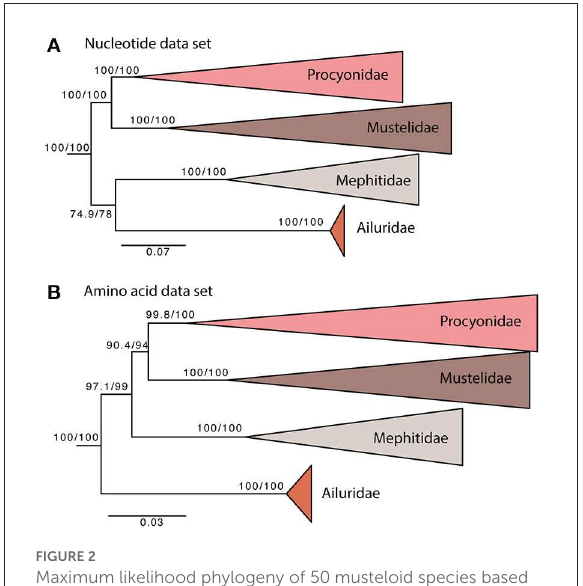
FIGURE2 Maximum likelihood phylogeny of 50 musteloid species based on nt (A) and aa (B) datasets. Pinnipedia was used as outgroup (pruned from tree). Values at each node represent SH-aLRT/UFBoot support in %. The scale bar indicates nucleotide substitutions per codon